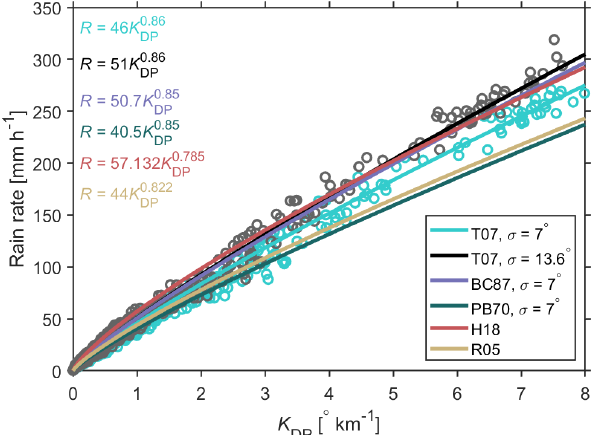
Figure 4. T-matrix-based simulation of K DP vs. rain rate from the OTT observations on 20 July 2021. Black and green circles in- dicate observations with σ = 7 and 13.6 ◦ , respectively, assuming the aspect ratio parameterization of Thurai et al. (2007, T07). The R(K DP ) relations from Ryzhkov et al. (2005, R05), Huang et al. (2018, H18), and Bringi and Chandrasekar (2001) with aspect ra- tio parameterizations from Pruppacher and Beard (1970, PB70) and Beard and Chuang (1987, BC87) are also